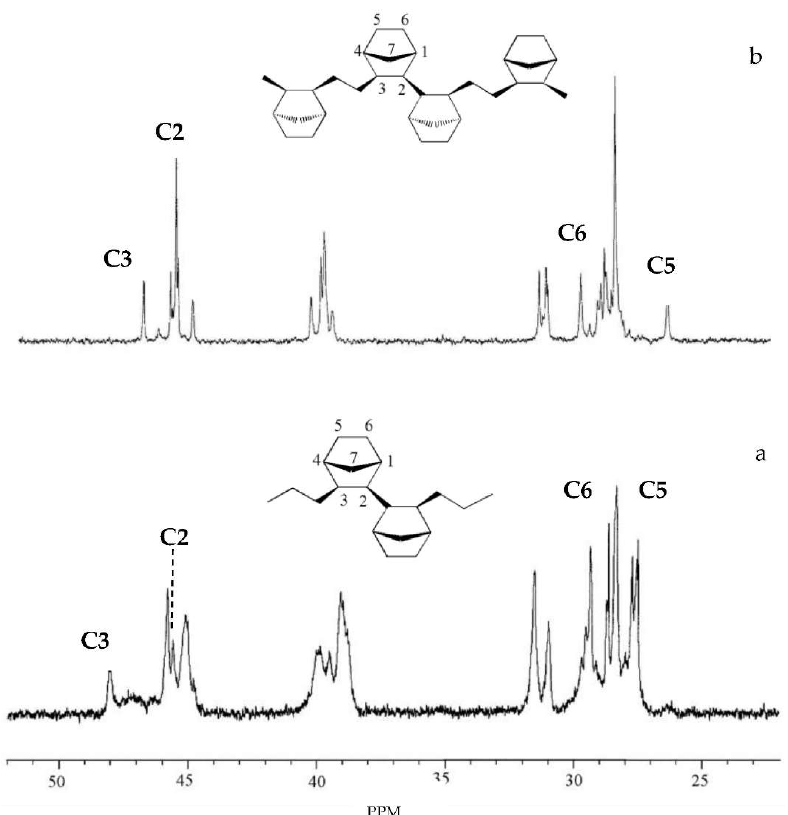
Figure 5. 13 C NMR spectra of a poly(E- co -N) produced by catalyst i -Pr[(Cp)(Flu)]ZrCl 2 ( 3 ) with 58 mol % of N) ( a ); and by catalyst rac -Et(Indenyl) 2 ZrCl 2 ( 1 ) with 33 mol % of N ( b ) [34].